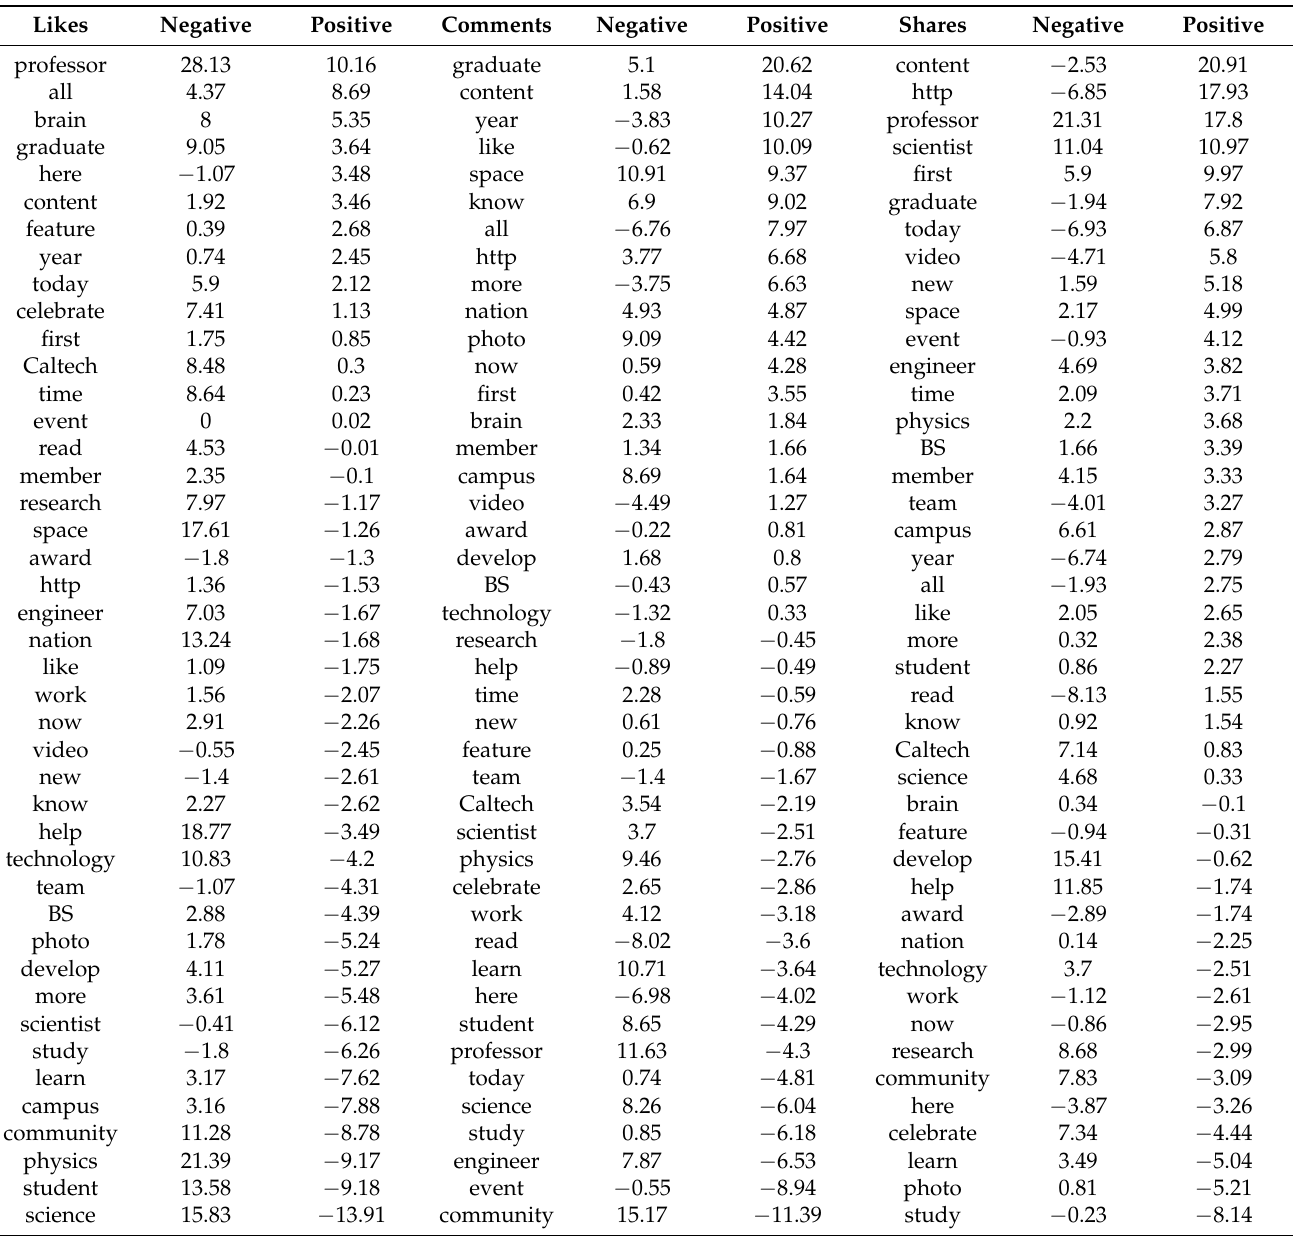
Table A3. Negative and positive clues (California Institute of